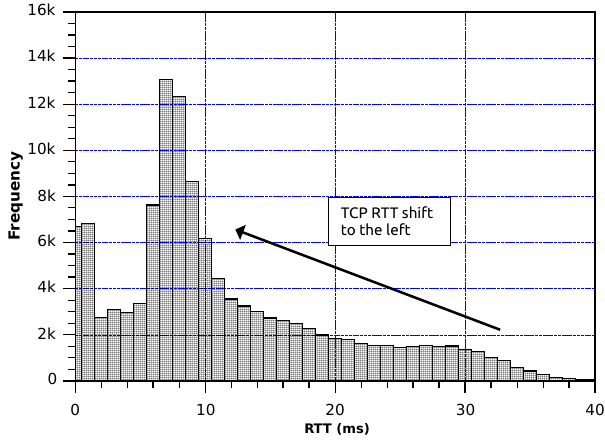
Figure 16. TCP session RTT histogram on router with a modified Linux kernel.